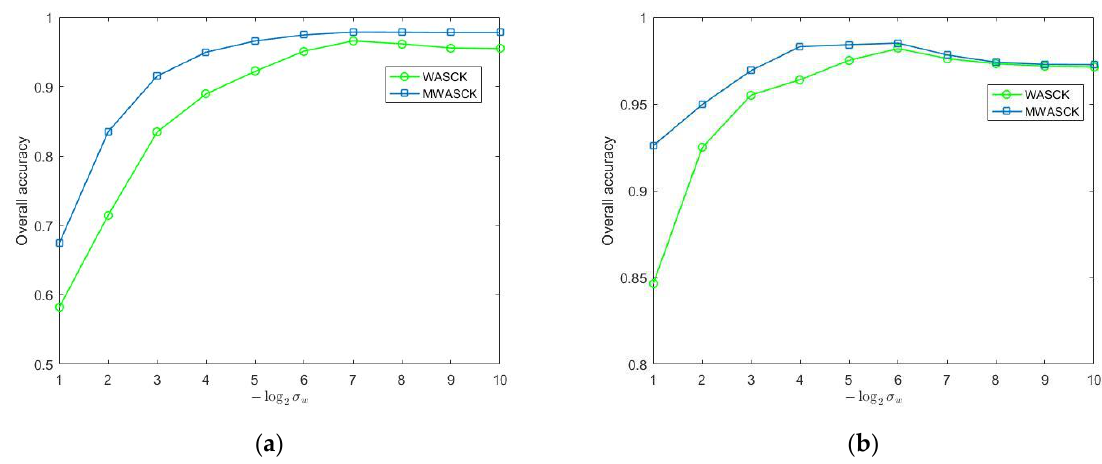
Figure 8. OA values under different kernel width 𝜎 𝑤 . ( a ) Indian Pines; ( b ) University of Pavia.